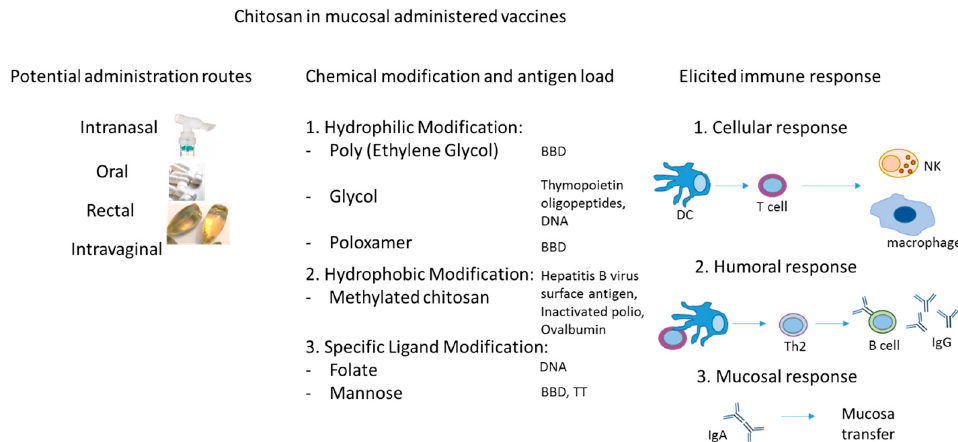
Figure 1. Properties of chitosan in the design of mucosal administered vaccines (i.e., administration mucosal routes, chemical modification for variate antigen load and applications, diverse elicited immune response). BBD = Bordetella bronchiseptica dermonecrotoxin, TT = Tetanus toxoid, DC = dendritic cell, Th2 = T helper 2 CD4 + cell, IgG = Immunoglobulin G antibodies, IgA = Immunoglobulin A antibodies.